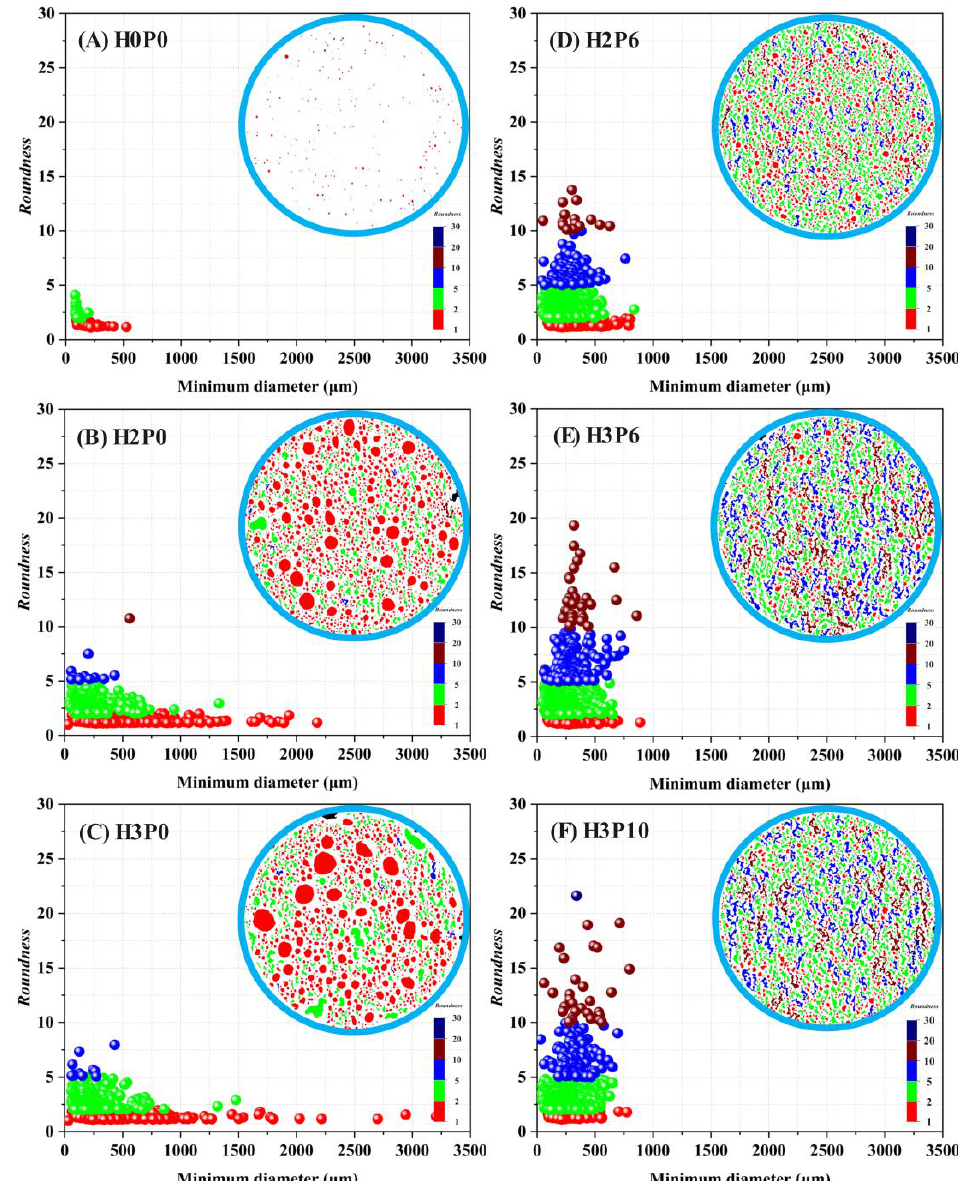
Figure 13. Cloud plots of pore roundness distribution of geopolymer foams: ( A ) H0P0, ( B )